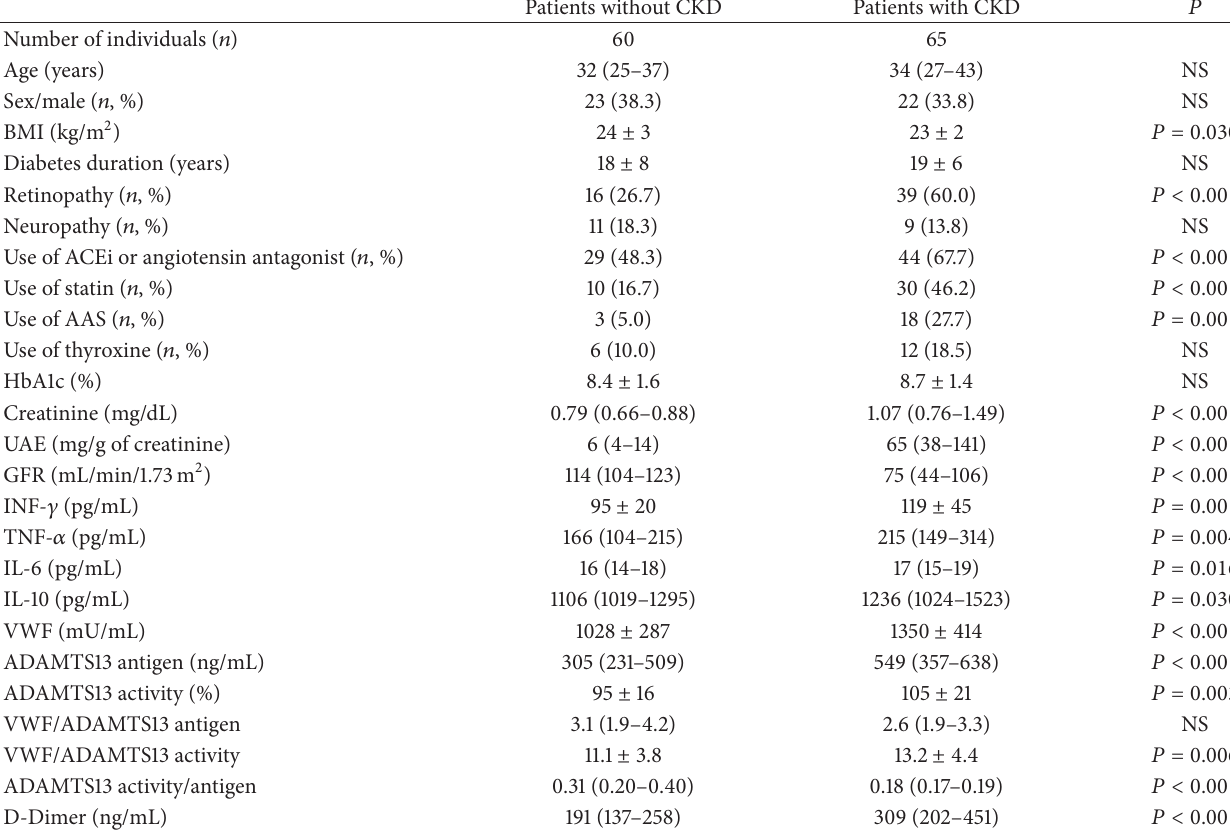
Table 1: Characteristics of type 1 diabetic patients with and without chronic kidney disease. Patients without